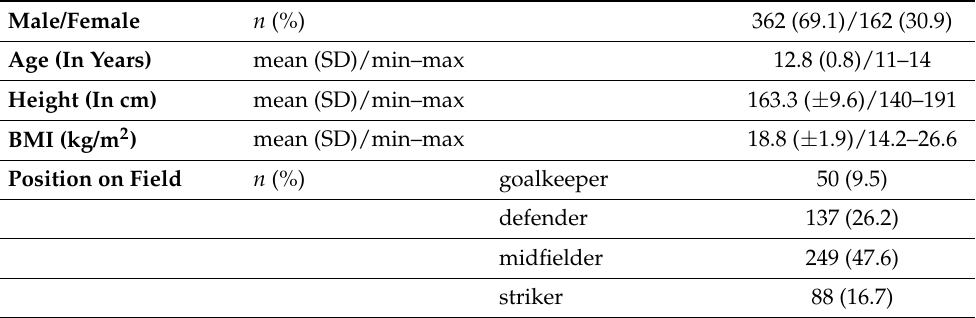
Table 2. General data of the study population.